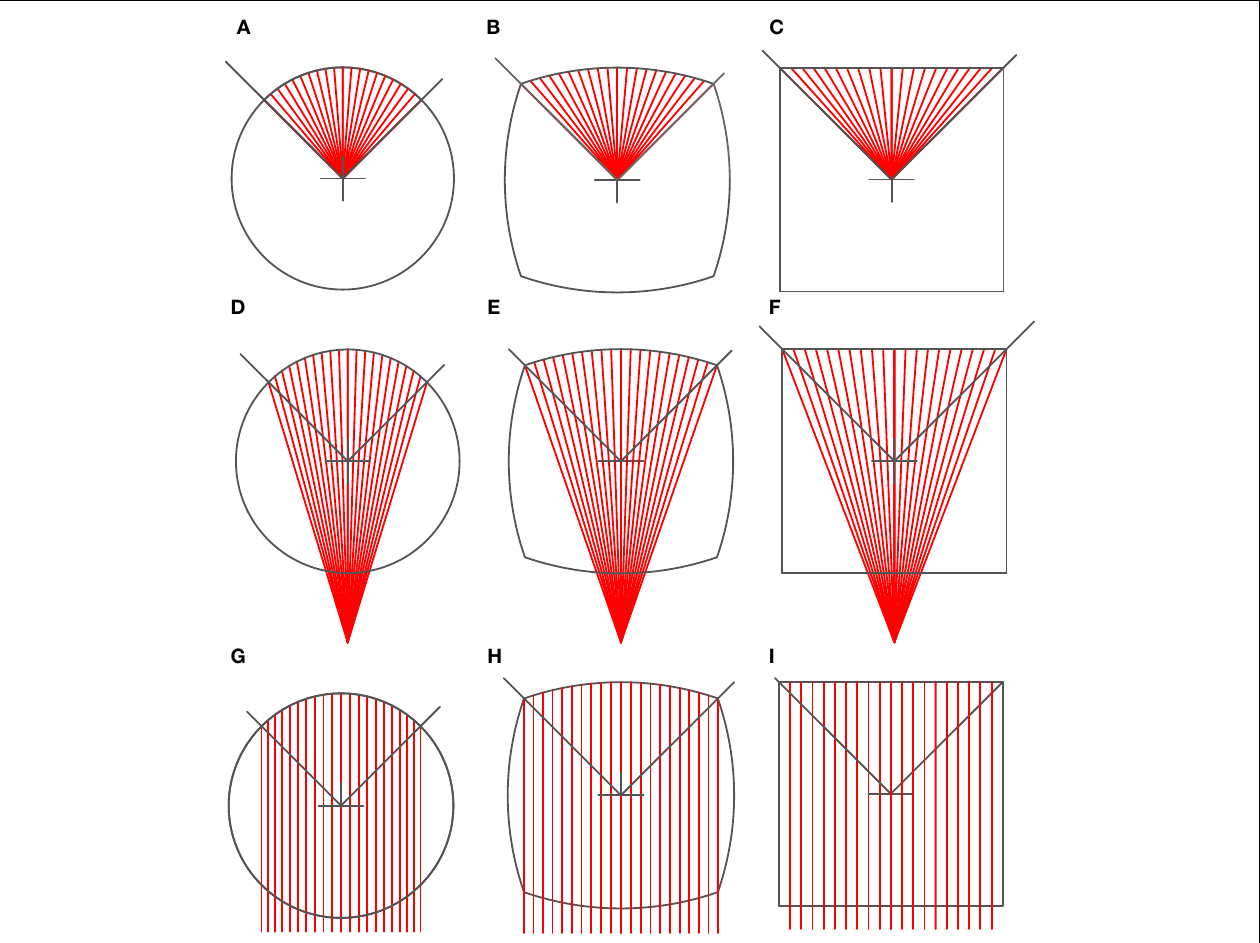
FIGURE 2 |Various Deformations of auxiliary radii lines. (A) circle-radial, (B) circlesquare-radial, (C) square-radial, (D) circle-elliptic, (E) circlesquare-elliptic, (F) square-elliptic, (G) circle-paraboloidal, (H) circlesquare-paraboloidal, (I) square-paraboloidal